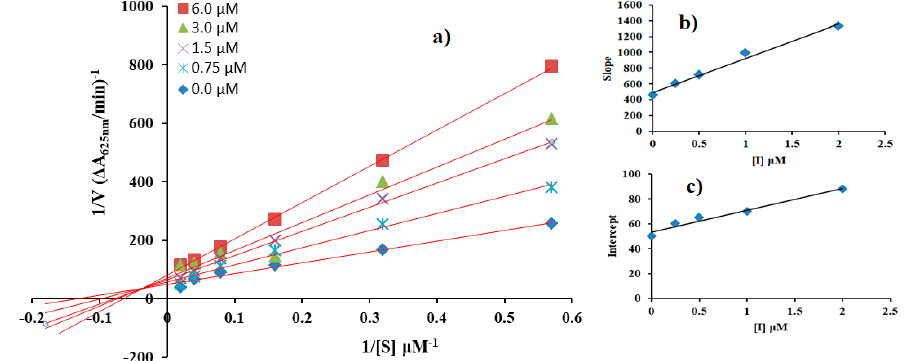
Figure 3. Kinetic analysis results for target molecule 3b . ( a ) Double reciprocal Lineweaver-Burk plots for the inhibition of Jack bean urease in the presence of compound 3b . Concentrations of 3b were 0, 0.25, 0.5, 1, and 2 µ M, respectively. Substrate urea concentrations were 1.57, 3.12, 6.25, 12.5, 25, and 50 µ M, used respectively; ( b ) The secondary replot of the Lineweaver-Burk plot, slope vs. various concentrations of 3b ; ( c ) The secondary replot of the Lineweaver-Burk plot, Intercept vs. various concentrations 3b .